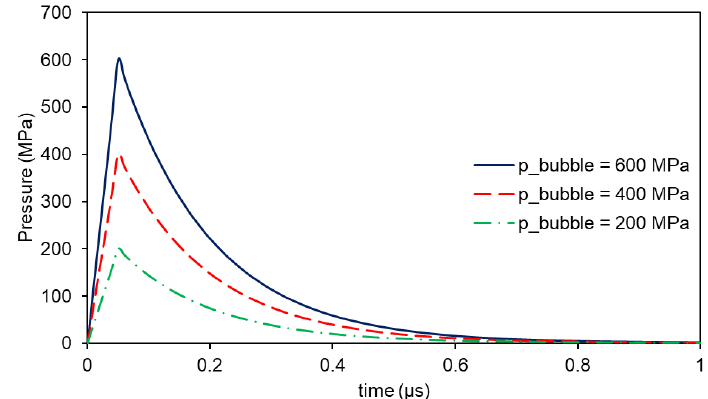
Figure 4. Pressure function considering a pressure peak of 600 MPa (blue solid line), 400 MPa (red dashed line), and 200 MPa (green dash-dotted line).